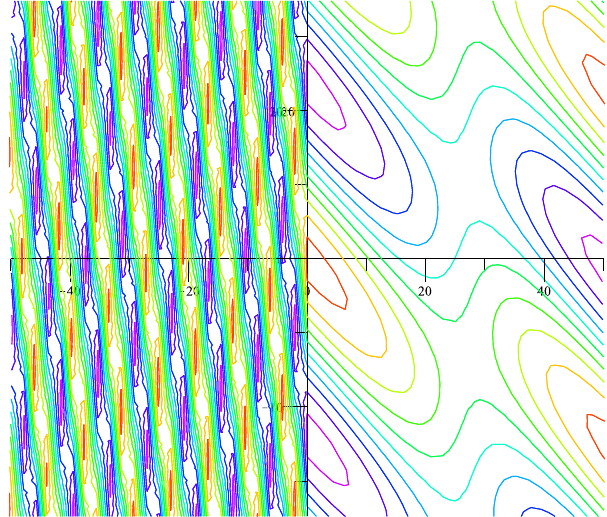
Figure 13. Contour map of H field with the incident angle θ i = 16 ◦ at the interface between the vacuum ( x < 0) and effective double positive material ( x > 0) when ω p t =